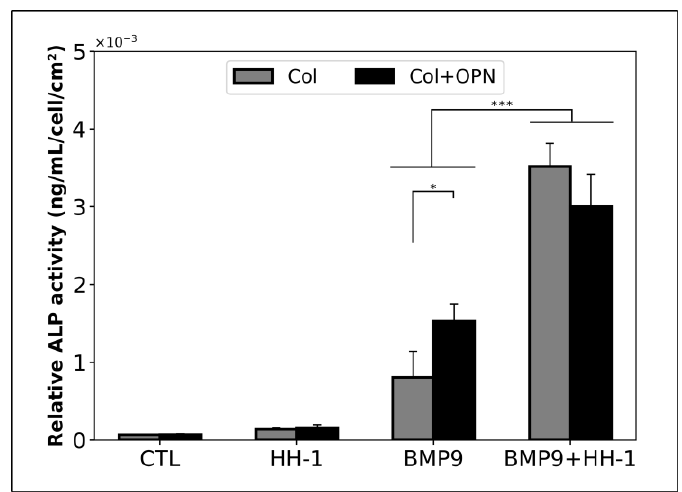
Figure 6. ALP activity relative to the cell number. hmrSCs were cultured on a collagen coating (Col) or a collagen and osteopontin (Col (0.1 mg/mL) + OPN (5 µg/mL)) coating and stimulated for 3 days with 0.1 nM BMP9 with or without HH serum (HH-1). The results are the mean ± SEM of 2 independent experiments performed in triplicate. * p < 0.05, *** p < 0.001.